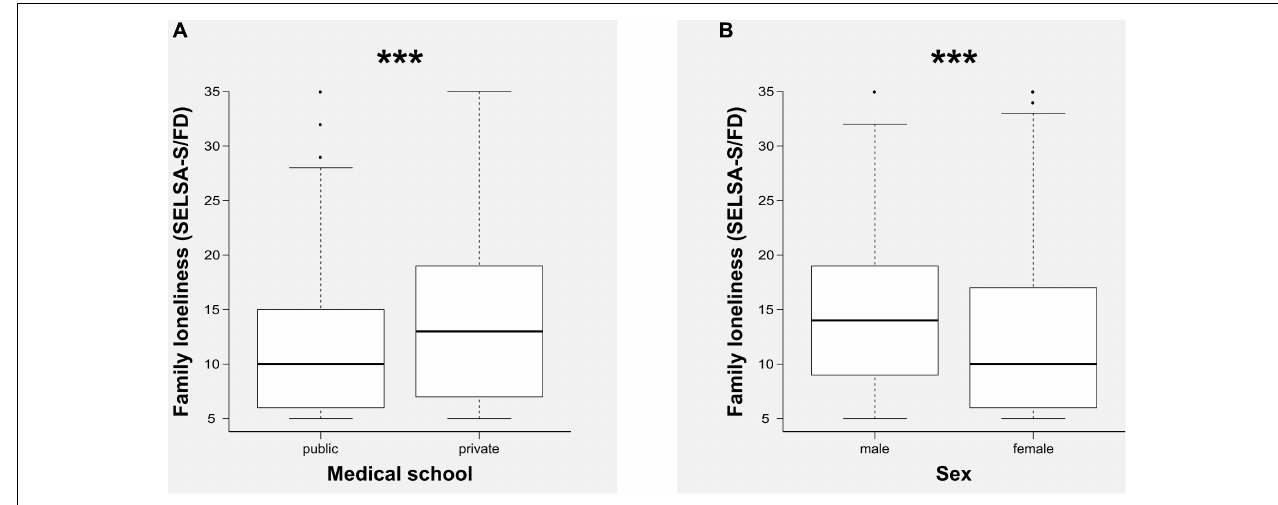
FIGURE 2 | Comparisons of the scores of family loneliness (family domain of the Social and Emotional Loneliness Scale for Adults, SELSA-S/FD) according to medical school (A) and sex (B) . ∗∗∗ p < 0.001.